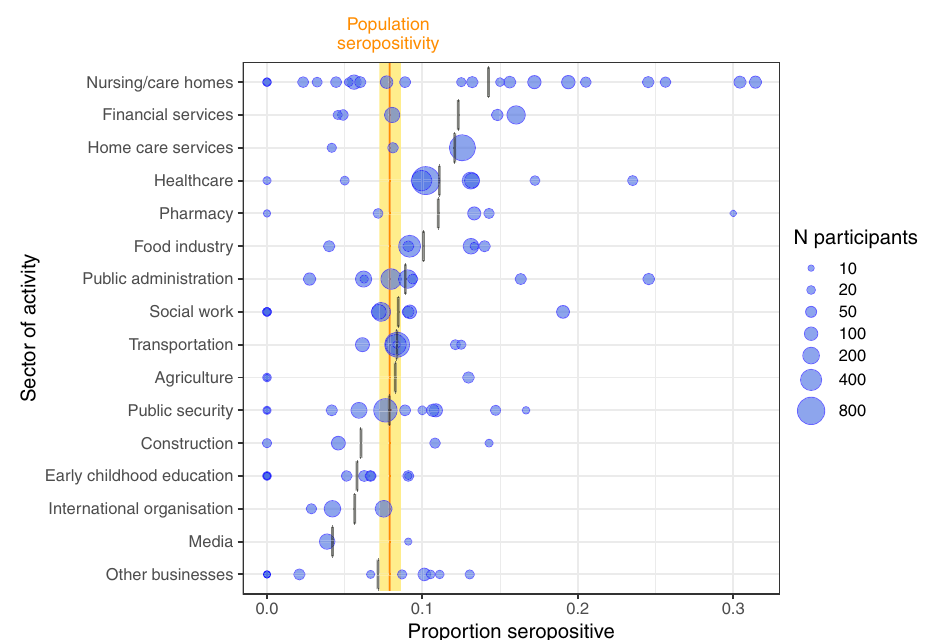
Fig. 1 Prevalence of anti-SARS-CoV-2 IgG antibodies by activity sector, SEROCoV-WORK + study, May – September 2020, Geneva, Switzerland. Sample size: 10,513 participants, 1026 of which were seropositive. Blue dots represent proportion of seropositive participants per company/workplace facility. Dot size indicates number of employees participating. Darker dots indicate more than one facility with same or very similar seropositivity rate. Vertical orange bar and yellow area indicate general working-age population seropositivity rate and 95% binomial con fi dence interval, respectively, from SEROCoV-POP study 20,21 . Small gray vertical bars show the proportion positive of all participants per sector. Facilities with <10 participants are not shown as dots, but these participants are included in the sector average.